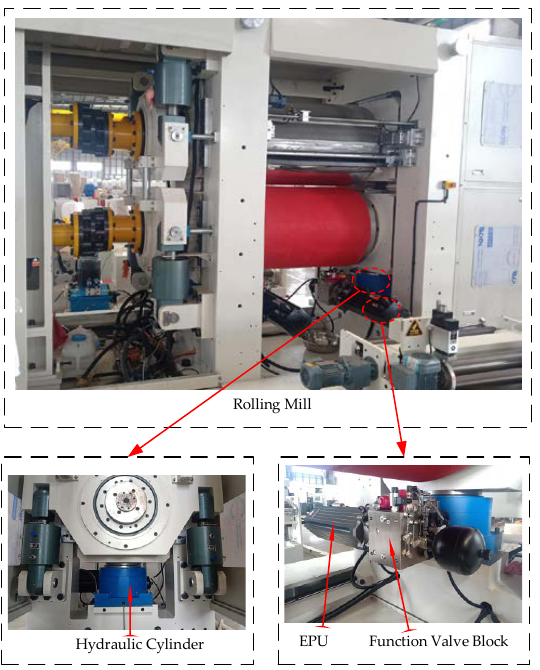
Figure 9. Experimental platform.